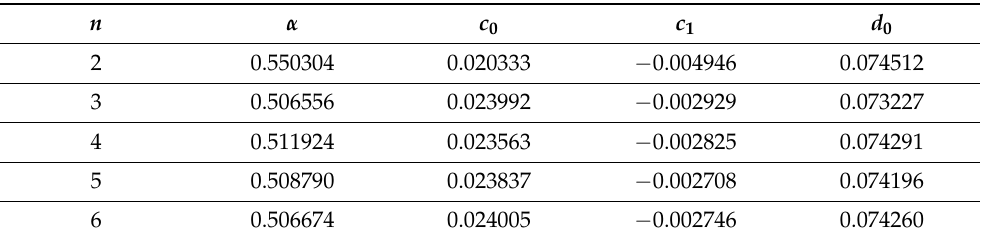
Table 1. The numerical calculation results of the undetermined constants c 0 , c 1 , α , and d 0 , where q = 1.8 × 10 − 3